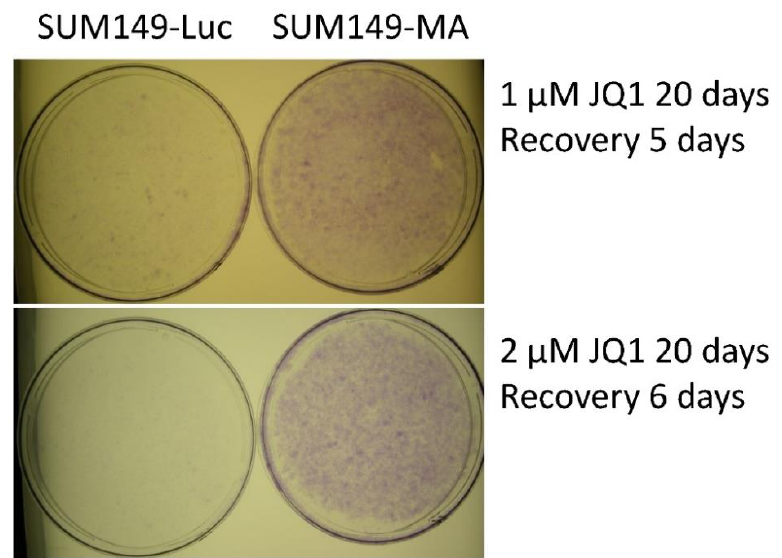
Figure 1. Resistance of SUM149-MA cells to treatment with JQ1. SUM149-MA and parental SUM149-Luc cells were treated in parallel with 1 or 2 µM of JQ1 for 20 days (treatment killed most of the cells in the parental cell line) and then allowed to recover and grow in a drug-free medium for 5 or 6 days (as indicated) before being stained with crystal violet. Passage numbers: SUM149-Luc, 6 passages in a medium with dialyzed FBS and glutamine; SUM149-MA, 7 passages in a glutamine-free medium followed by 6 passages in a medium with dialyzed FBS and glutamine.